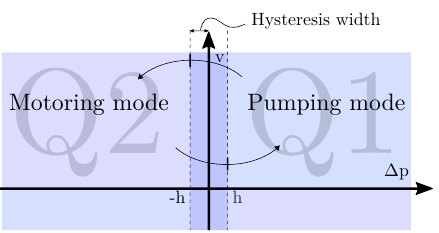
Figure 5. Hysteresis control of a hybrid system. The variable x denotes an arbitrary property and h is the hysteresis width.